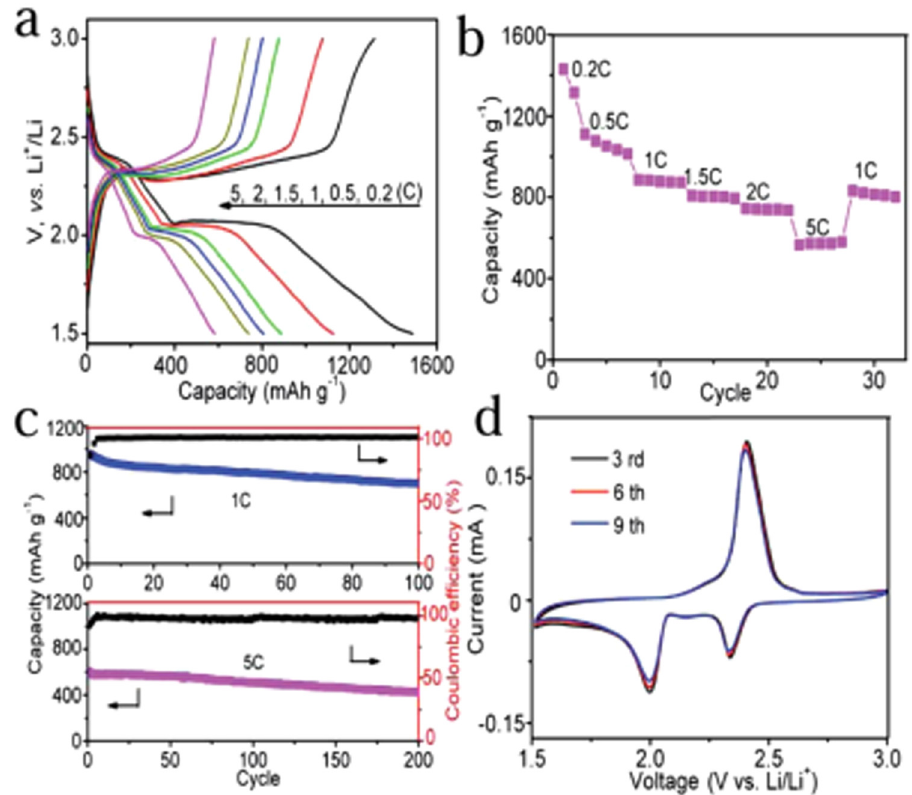
Figure 9: Electrochemical performance of VACNTs@CNFs - S for Li – S battery between 3 and 1.5 V versus Li + /Li: ( a ) charge – discharge voltage pro fi les and ( b ) rate performance at di ff erent current densities [ 70 ] . Copyright 2017, American Chemical Society, ( c ) cyclic stability test at